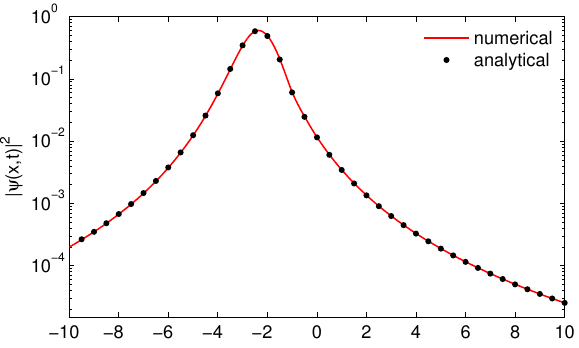
Figure 8. Comparison between the analytical solution Equation ( 25 ) and the matrix approach Equation (62) for the case of a liner potential with β =